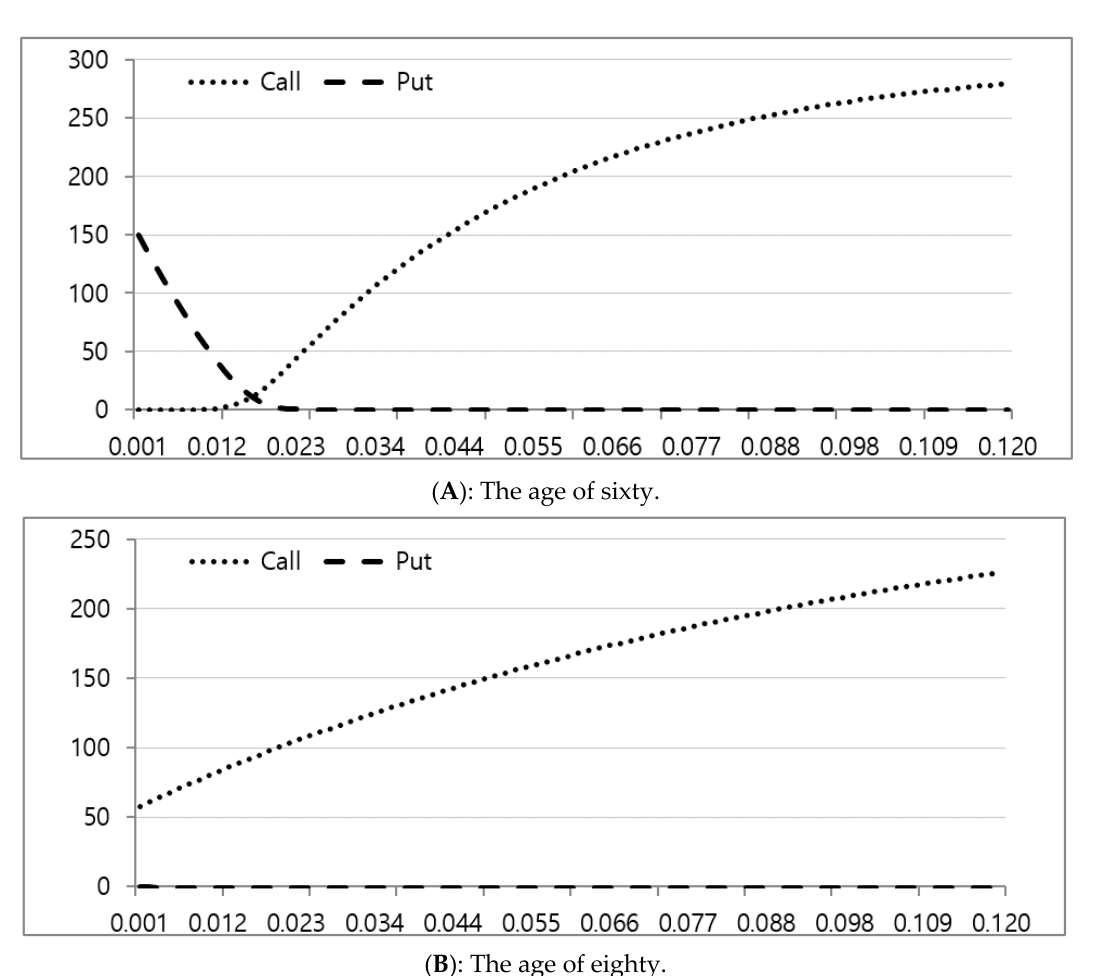
Figure 4. Risk-free rate sensitivity analysis. This figure exhibits the estimated total option value by age